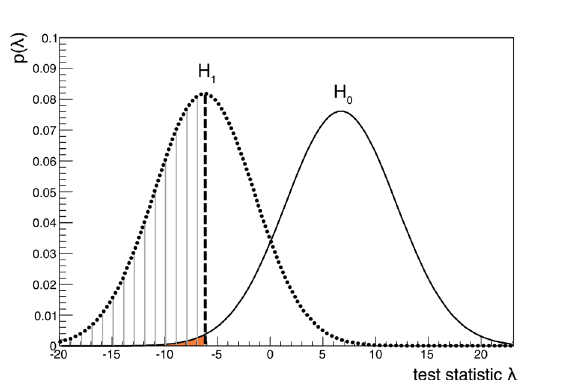
Figure 1. The distribution of the test statistic λ from eq. 1 for the “no Moon shadow” hypothesis H 0 (full curve) and the “Moon shadow” hypothesis H 1 (dotted curve). The dashed area corresponds to the 50% of the pseudo-experiments where the Moon shadow hypothesis H 1 is correctly identified. The tiny shaded area quantifies the expected median significance of 3.4 σ to observe the Moon